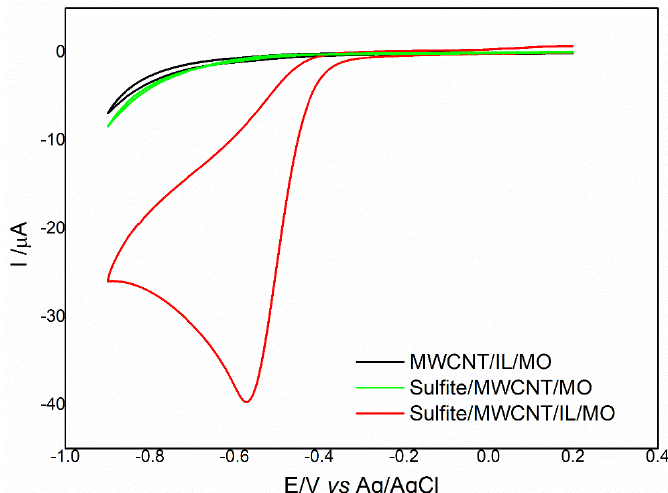
Figure 4. Cyclic voltammetry in absence (black line) and presence (red and green lines) of 5 mmol L − 1 sulfite, in BRB (pH 1.81). Scan rate: 100 mV s -1 (1 cycle).